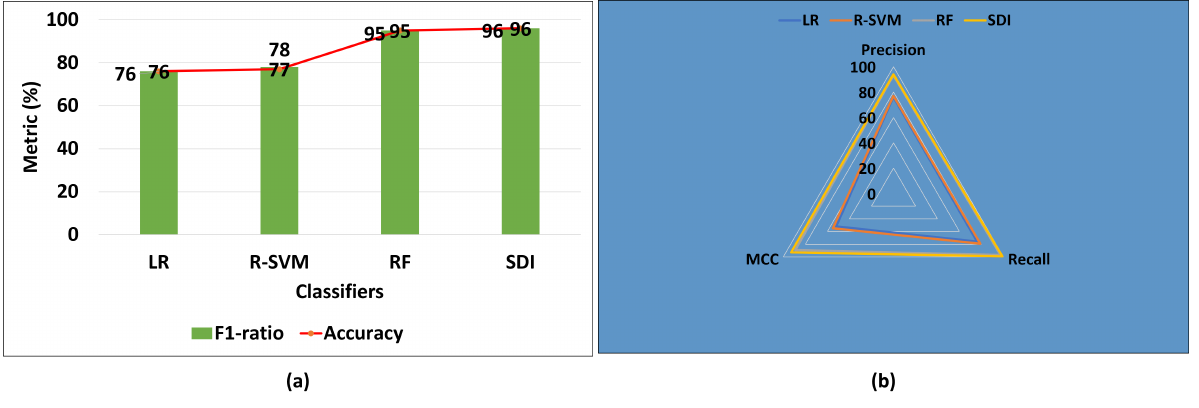
Figure 7. SDI comparison with existing algorithms to identify